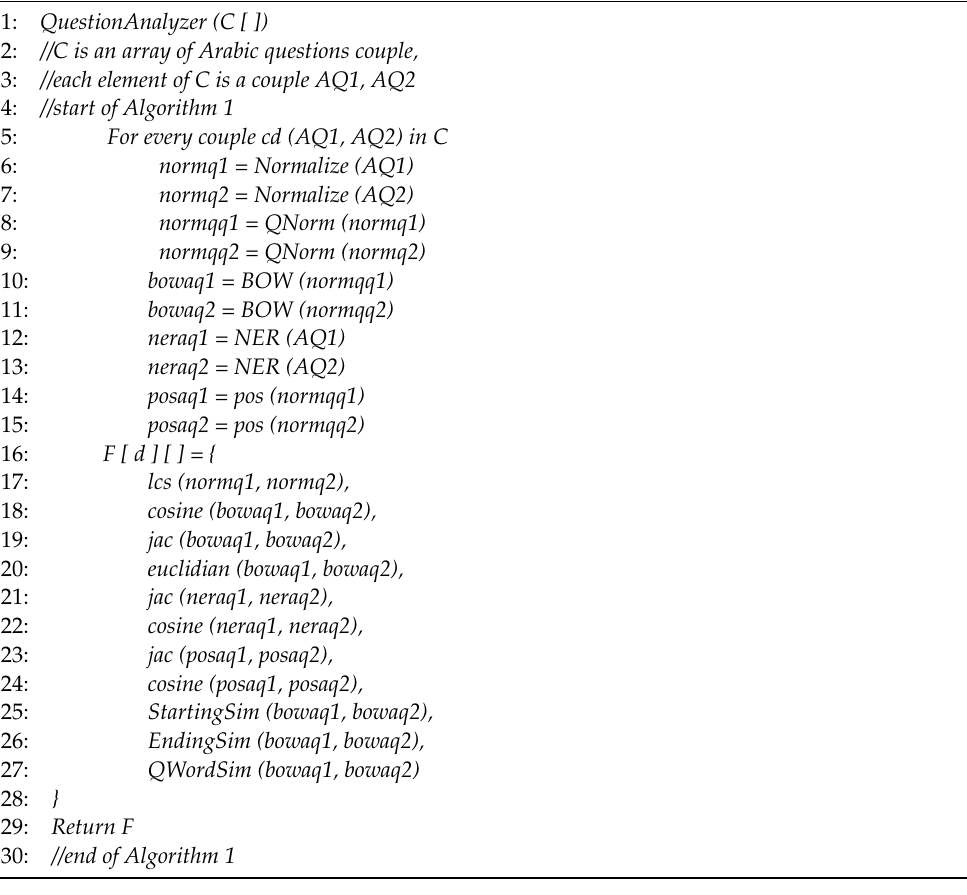
Algorithm 1: Main algorithm for processing question